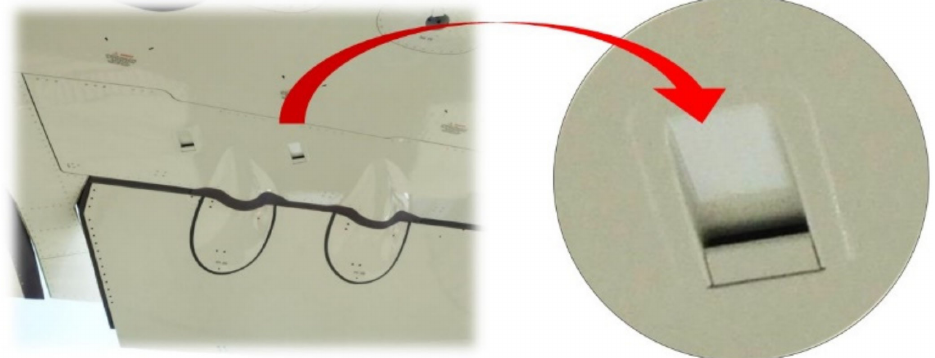
Figure 11. Underwing scoops for the cooling of Airbus A350 aileron